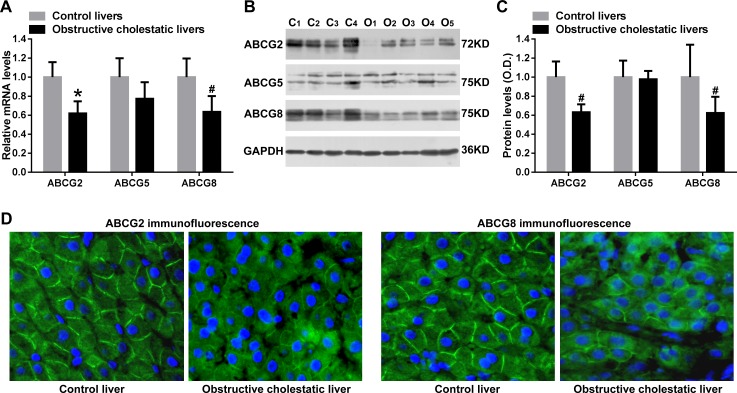
Hepatic canalicular membrane transporters ABCG2 and ABCG8 expression in human obstructive cholestasis.(A) Real-time qPCR analysis of mRNA levels of canalicular membrane transporters ABCG2, ABCG5 and ABCG8 (% of control group, n = 22 for each group). (B) Representative Western Blotting for ABCG2, ABCG5 and ABCG8 and (C) their corresponding densitometry (% of control group, n = 22 for each group). (D) IF labeling of ABCG2 and ABCG8 protein (green) in the livers from patients with obstructive cholestasis and controls. Nuclei of hepatocytes from liver samples were stained with DAPI (blue). C, controls; O, obstructive cholestasis liver samples. *p < 0.01; #
p <0.05 versus controls. DAPI, 4′, 6-diamidino-2-phenylindole.